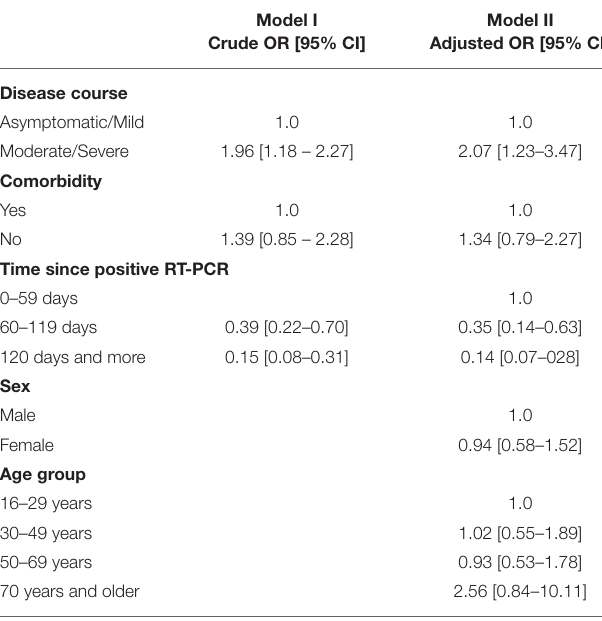
TABLE 3 | Factors associated with the presence of SARS-CoV-2 neutralizing TABLE 2 | Factors associated with the presence of SARS-CoV-2 IgG antibodies antibodies ( n = 412). ( n = 412). Model I Model II Model I Crude OR [95% CI] Adjusted OR [95% CI] Crude OR [95%